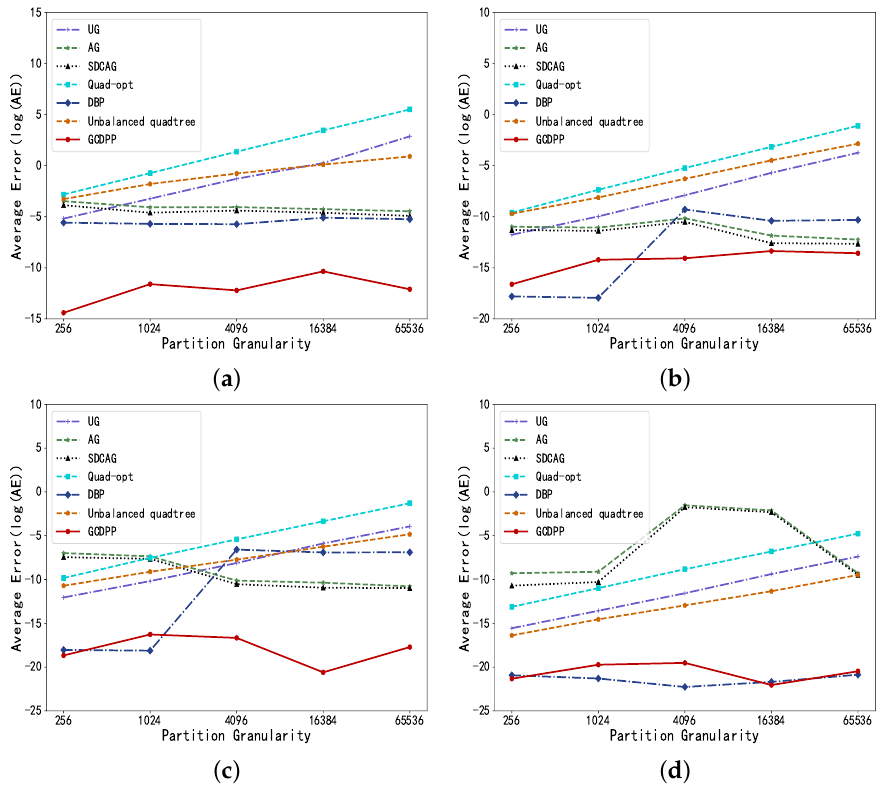
Figure 16. Partition granularity vs. average error. ( a ) Storage dataset, (cid:101) = 1; ( b ) Landmark dataset, (cid:101) = 1; ( c ) Checkin dataset, (cid:101) = 1; ( d ) Yellow_trip dataset, (cid:101) =